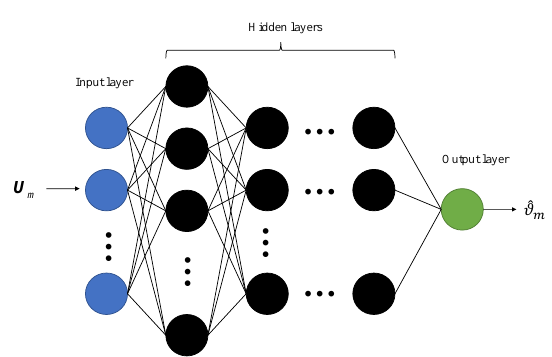
Figure 4. The structure of the proposed DNN for BER